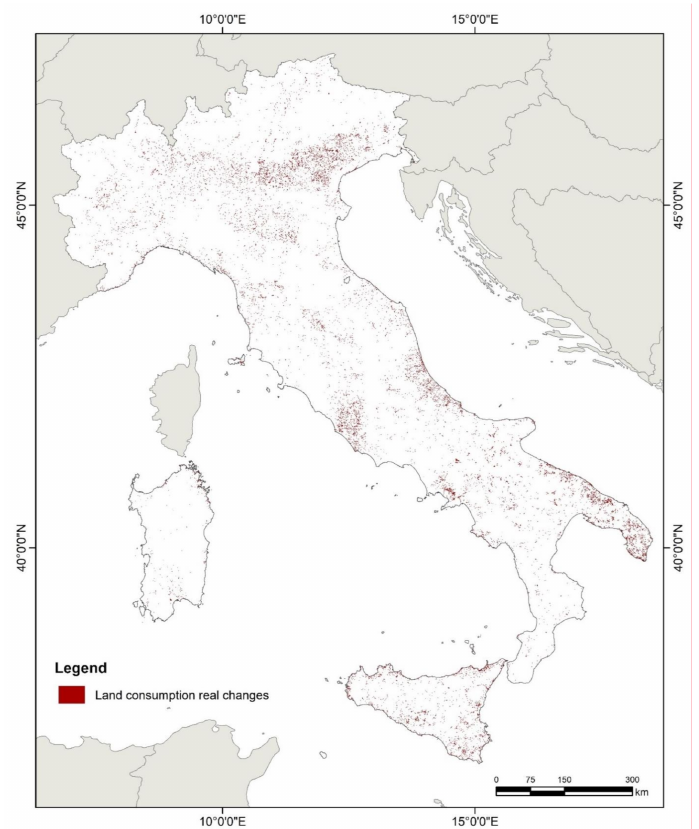
Figure 9. Land consumption changes (2018–2019) monitored by ISPRA-SNPA.